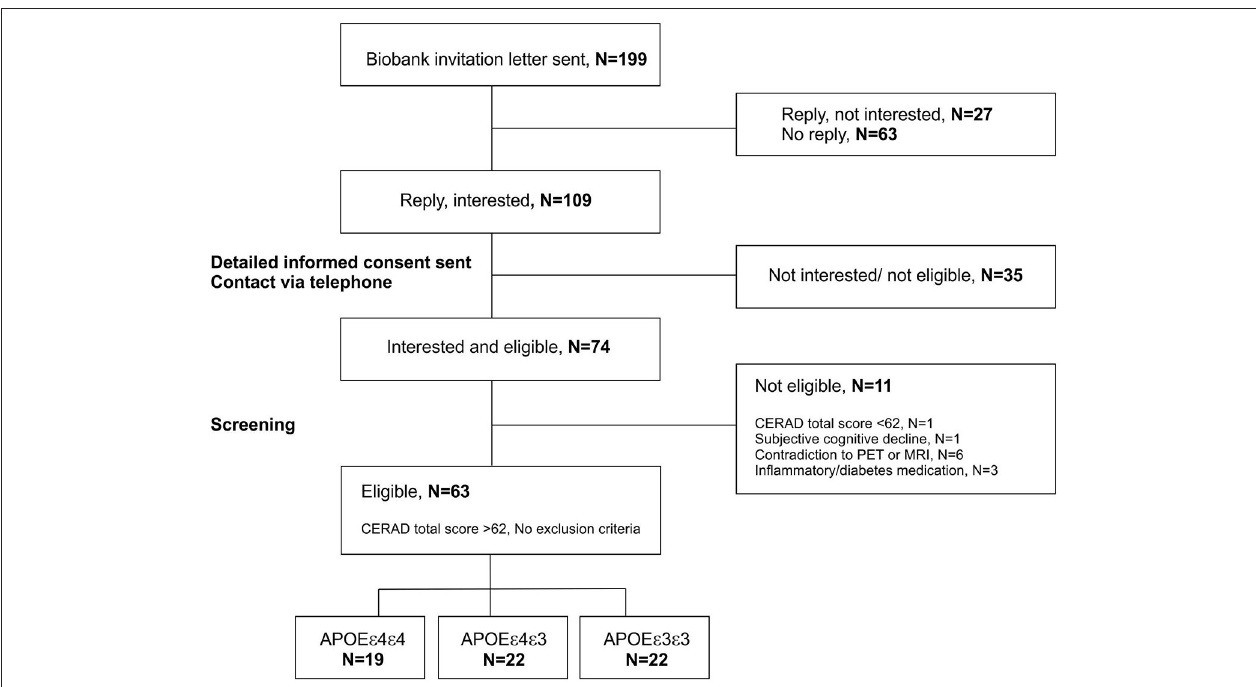
FIGURE 2 | Recruitment scheme for the ASIC-E4 study. Recruitment is done in collaboration with the local biobank (Auria Biobank, Turku, Finland). The biobank was able to send invitation letters based on a biobank consent, directly to individuals with known APOE genotypes. The signed letters of interest including the contact information of the invited individuals, and written informed consent for transforming the APOE status from the biobank to the study site were returned to the responsible researcher by the invited individuals. Subsequently, researchers contacted interested individuals by telephone and if no obvious exclusion criteria was present, invited them to a screening visit. At screening, all interested individuals were interviewed and evaluated with Consortium to Establish a Registry for Alzheimer’s Disease (CERAD) neuropsychological test battery. If calculated CERAD total score was > 62 points, and no other exclusion criteria was present, individuals were enrolled to the study. APOE, apolipoprotein E gene; PET, positron emission tomography; MRI, magnetic resonance